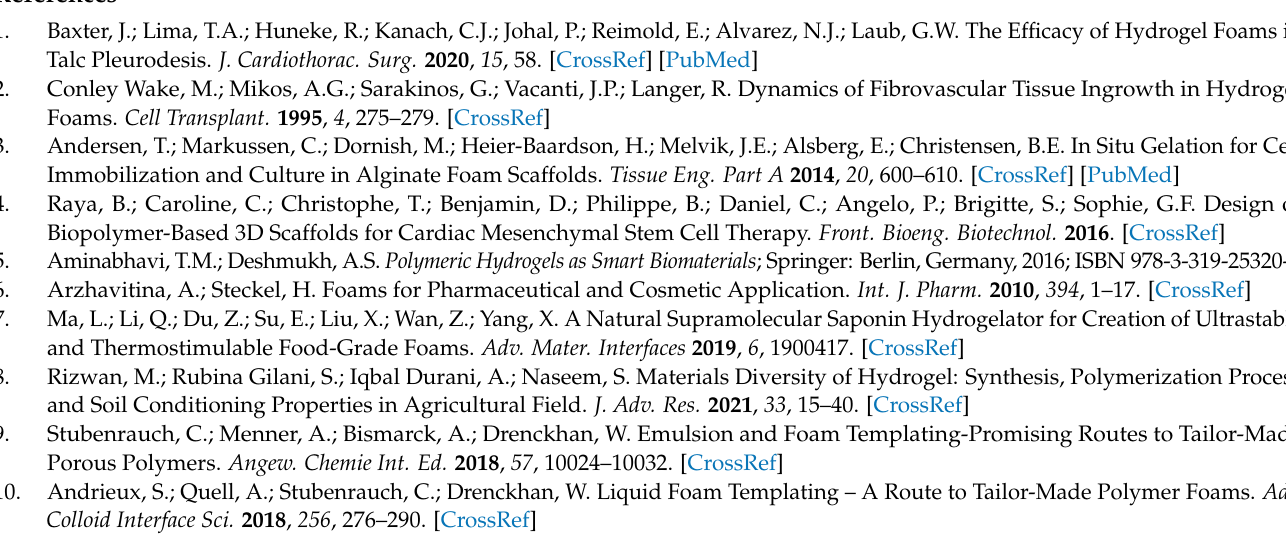
and area measurement [51]; Figure S4. Top—Setups for introducing (a) CO 2 or (b) N 2 flow into the rheometer. The central picture shows a zoom-in on the double-wall ring (DWR) geometry used for this experiment, in which the sample was loaded. Bottom—Schematic drawings of the corresponding setups; Figure S5. Left: Simple compression tests on a hydrogel foam obtained by foaming a mixture of 1 wt% alginate, 0.02 M CaCO 3 , 2 wt% Disponil APG 425, and 5 × 10 − 5 M bromothymol with CO 2 /air = 50/50. Right: Obtained values of the applied stresses as a function of the resulting de- formation with a linear fit [36,53]; Figure S6. Amplitude sweep test on a hydrogel (1 wt% alginate, 0.02 M CaCO 3 , 1 wt%) gelled using GDL instead of CO 2 . Figure S7. Percentage of released